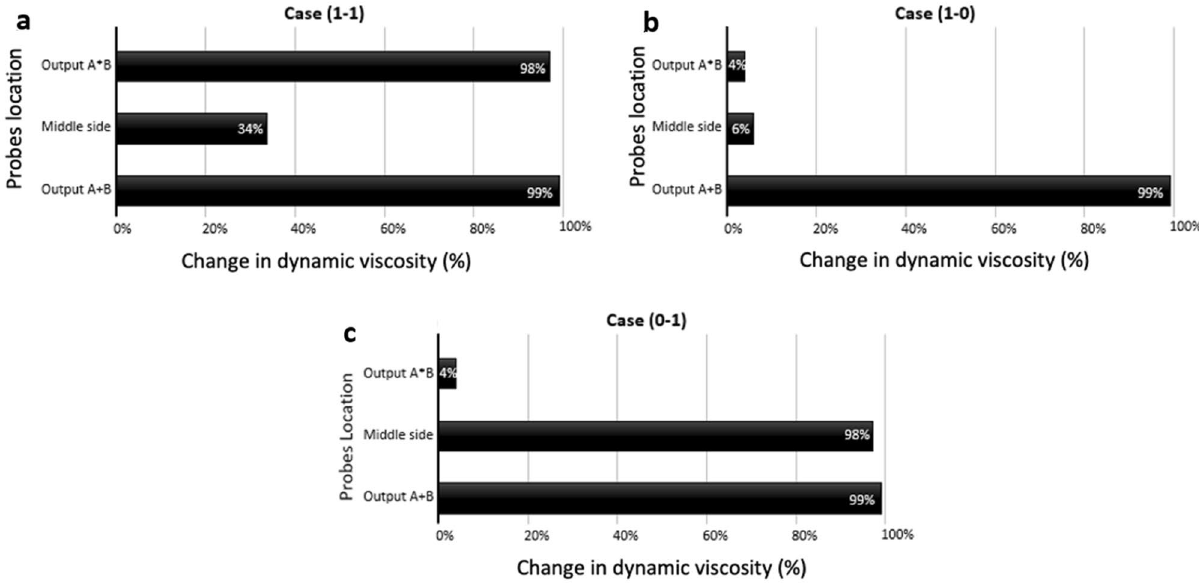
Figure 4. The change in dynamic viscosity of the bubble/liquid for the logic AND-OR type 2 gate circuit. The percentage change of dynamic viscosity of the bubble/fluid at three different points of the microfluidic network: Output A + B , Middle side, Output A ∗ B . ( a ) Case (1–1), ( b ) Case (1–0), ( c ) Case (0–1). In all graphs, the percentage change of dynamic viscosity for the OR output branch is almost equal to 100%. In the logic condition (1–1), the percentage change of dynamic viscosity is almost 35% because the bubbles may choose their path to the other output